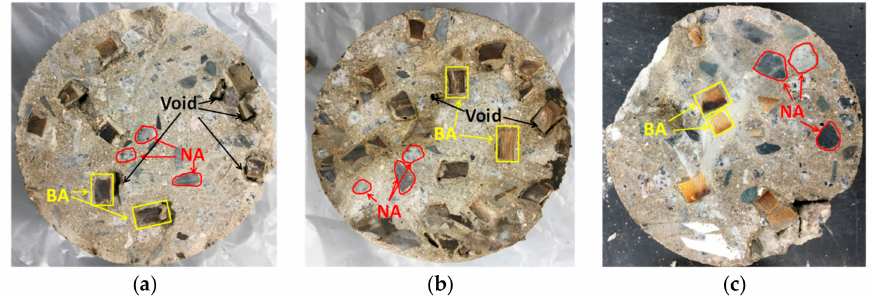
Figure 5. Cutting plane of concrete with bamboo chips: ( a ) Dried bamboo, ( b ) coated bamboo, ( c ) wetted bamboo.